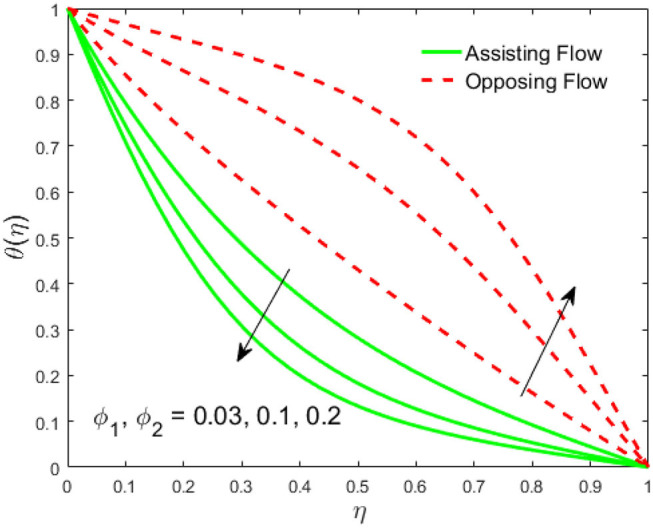
Impact of ϕ1, ϕ2 on θ(η).